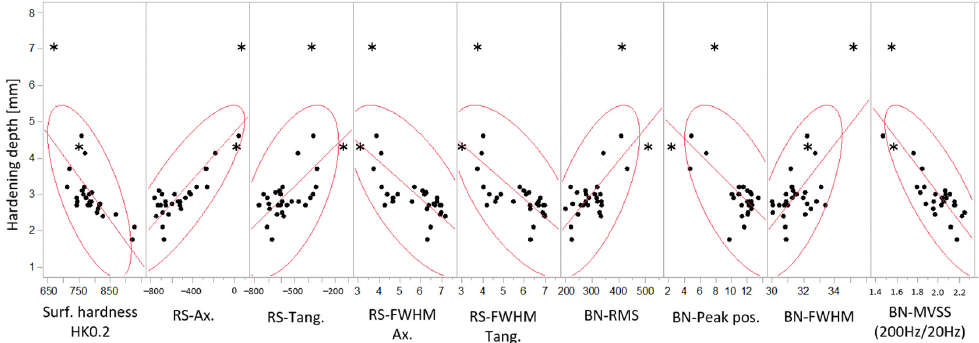
Figure 10. Varying correlation between actual hardness depths at 400 HV versus different predictors, surface hardness, RS, and BN monitoring characteristics. Possible outliers marked with (*). The color-coded matrix of correlations in Figure 11 reveals a heavy bi-variate corre- lation between the predictors themselves and with the hardening depth. This fact prevents using an ordinary linear regression approach, which assumes predictor independence.